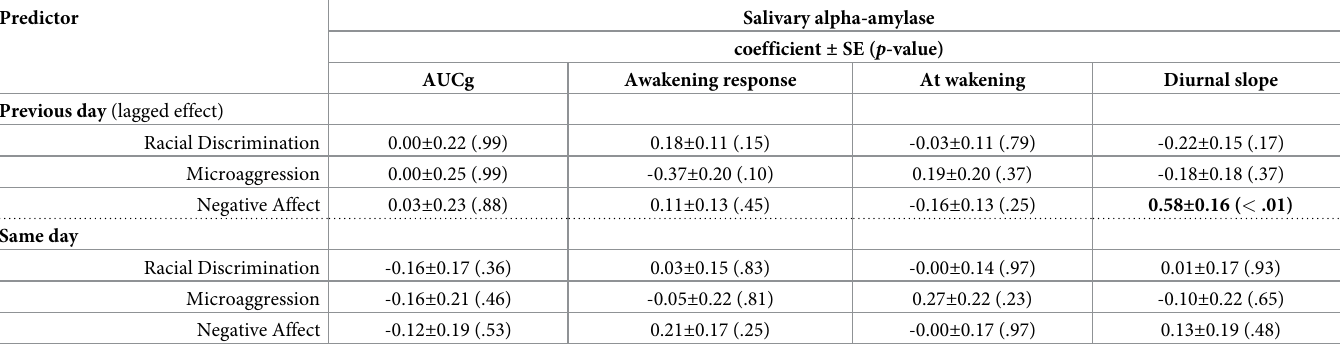
Table 5. Within-person effect of racial discrimination, microaggressions, and negative affect on salivary alpha-amylase.